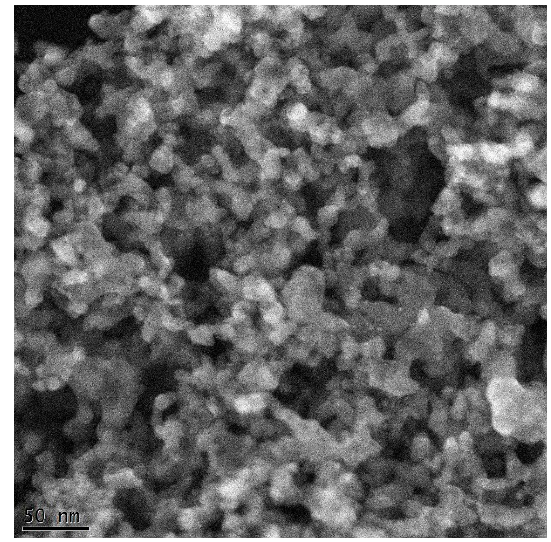
Figure 4. Morphology of Al 2 O 3 nanoparticles in a polymer binder.